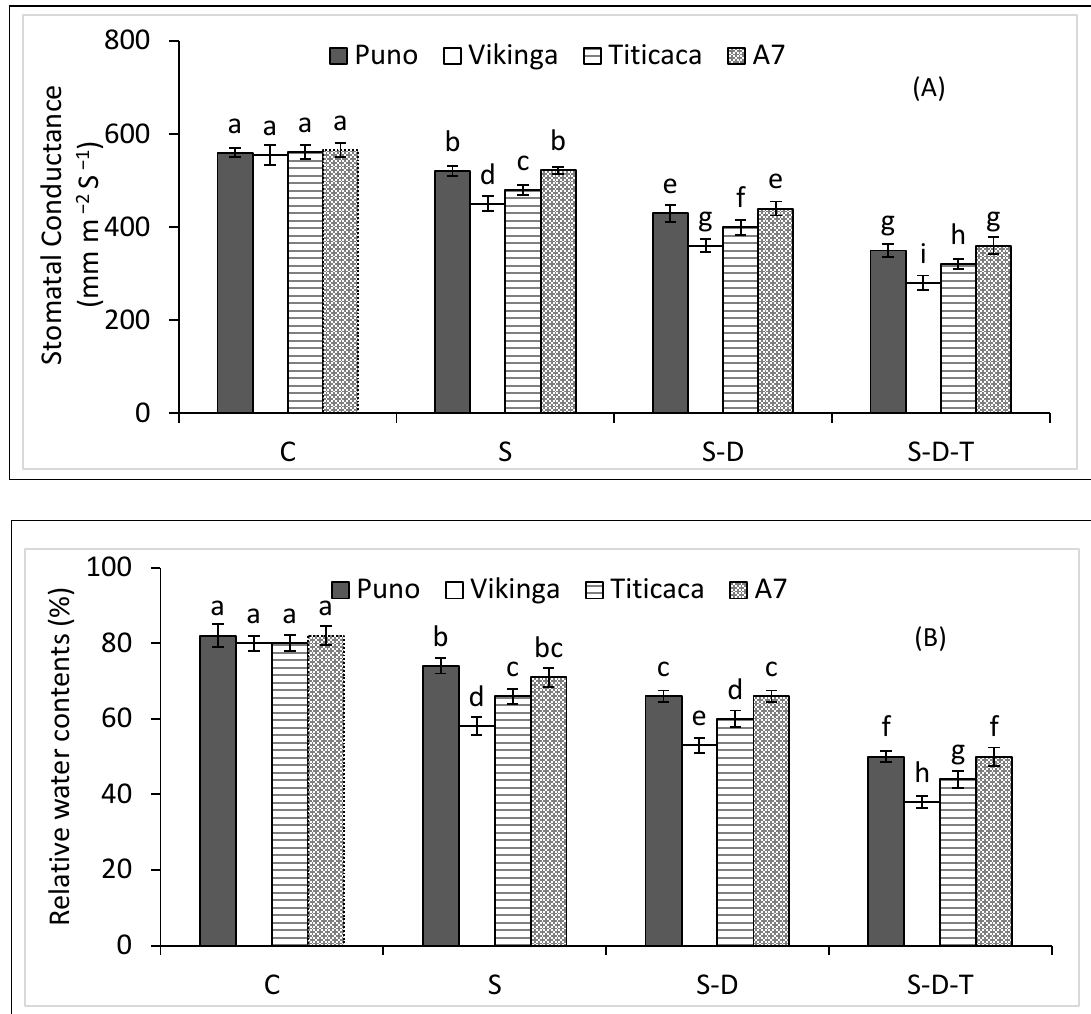
Figure 1. ( A ) Chlorophyll a, ( B ) chlorophyll b, and ( C ) total chlorophyll concentrations of quinoa genotypes under control (C), salinity (S), drought (D), and high-temperature (T) stress. S-D, combined salinity and drought treatment; S-D-T, combined salinity, drought, and high-temperature treatment. The values for each parameter are the means of three replicates ± SE. At the 5% probability level, bars with different letters indicate significant differences.